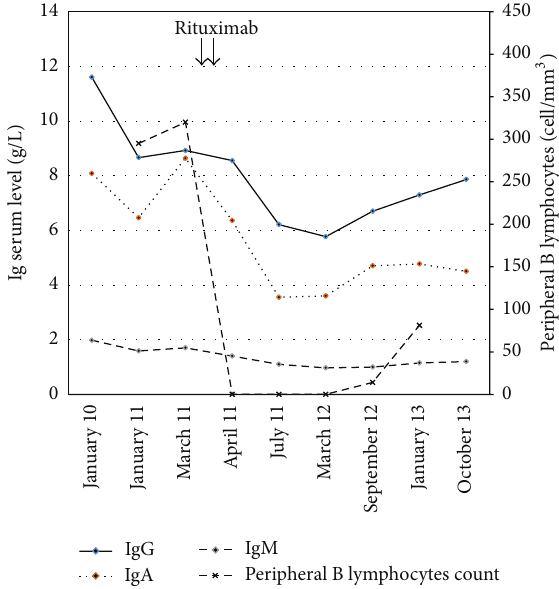
Figure 2: Corticosteroid daily doses received before and after rituximab treatment. Figure 3: Serum immunoglobulin (Ig) levels and peripheral B lymphocytes count before and after rituximab